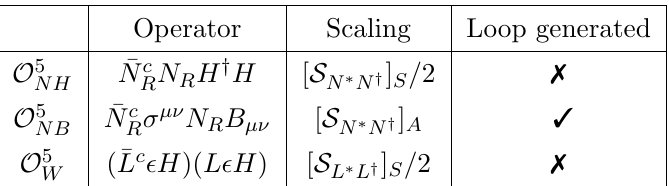
Table 2 . Dimension (cid:12)ve operators constructed with the SM and the RH neutrino (cid:12)elds. We also show the scaling of their Wilson coe(cid:14)cients in terms of the spurions of eq. (3.7) and eq. (3.9), and whether they are generated at one loop in a general UV completion. The additional factor of 1 = 2 is conventional and allows to simplify the mass matrix in eq.